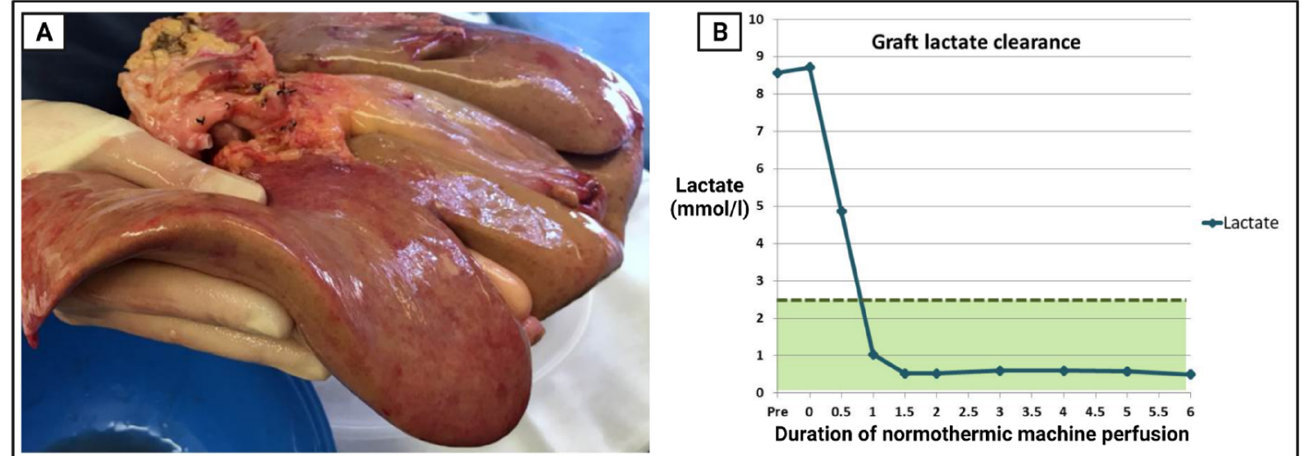
Figure 1. Suboptimal donor liver graft declined by all other transplant centres, subsequently preserved and assessed with normothermic machine perfusion (NMP). 56-year-old male donor with elevated BMI (30.5), smoker, and intracranial haemorrhage as cause of death. Donor liver index = 0.53 and donor risk index = 1.67. ( A ) Macroscopic steatosis evident with blunting of the left lobe edges and pale colour. ( B ) Perfuse lactate clearance during NMP. Despite suboptimal appearance, the hepatocytes cleared lactate to <2.5 mmol/L in just over an hour.